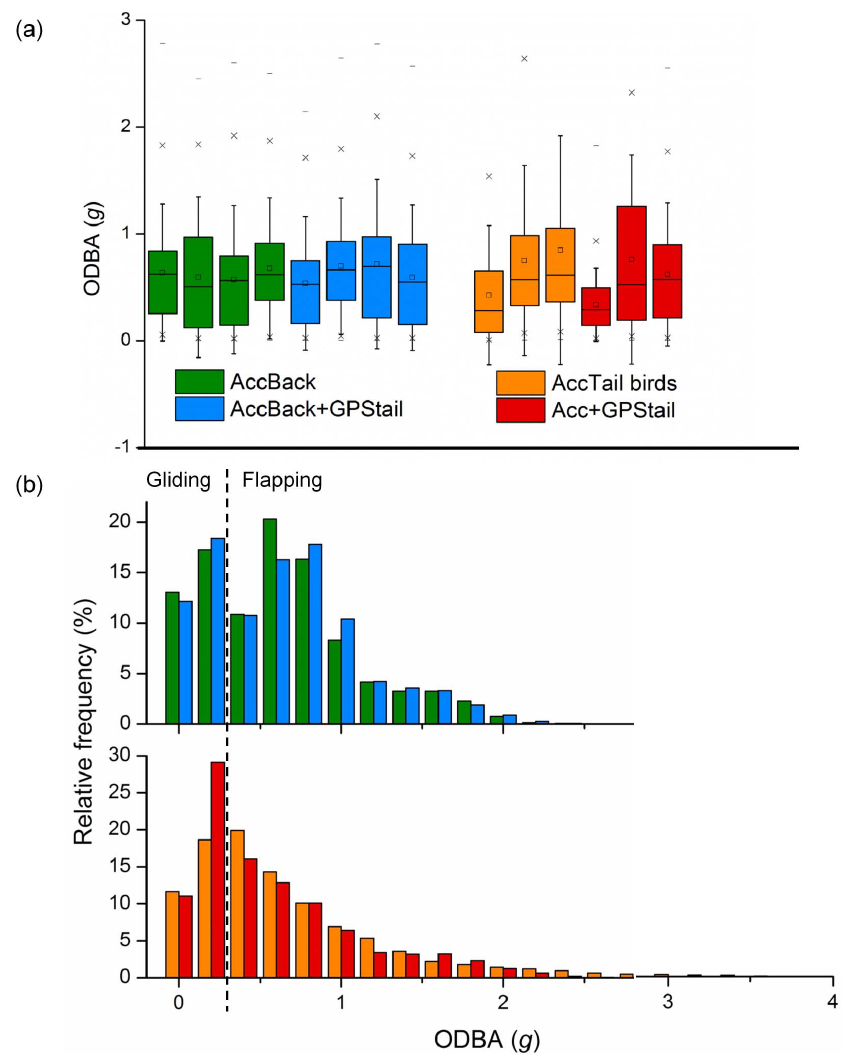
Figure 5. Comparison of the energy expenditure of flying gannets with or without GPS. (a) Box charts of the proxy for energy expenditure ODBA [21] calculated for flying gannets fitted with solely an accelerometer on their back or tail (green and blue bars respectively grouped as the non- GPS birds), or with, in addition to the accelerometer, a GPS under the tail (orange and red bars respectively grouped as the GPS birds). This illustrates that the mean ODBA remains similar between the groups despite their different treatments. (b) Frequency distribution of ODBA obtained for the different groups of birds cited above. This figure shows that a higher number of ODBA values is obtained for GPS birds compared to non-GPS birds.